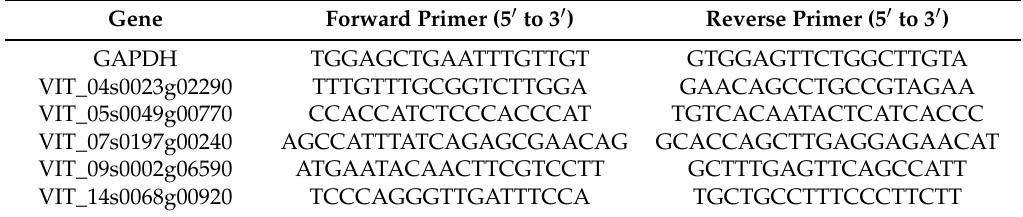
Table 3. Primers for